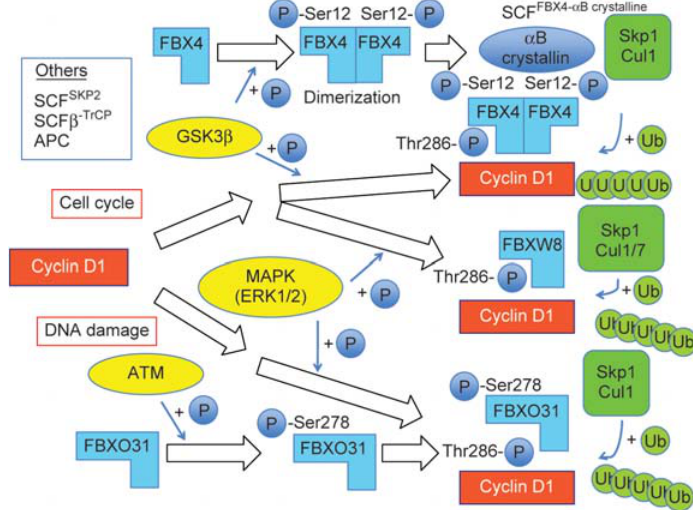
Figure 2 E3 ubiquitin ligases for cyclin